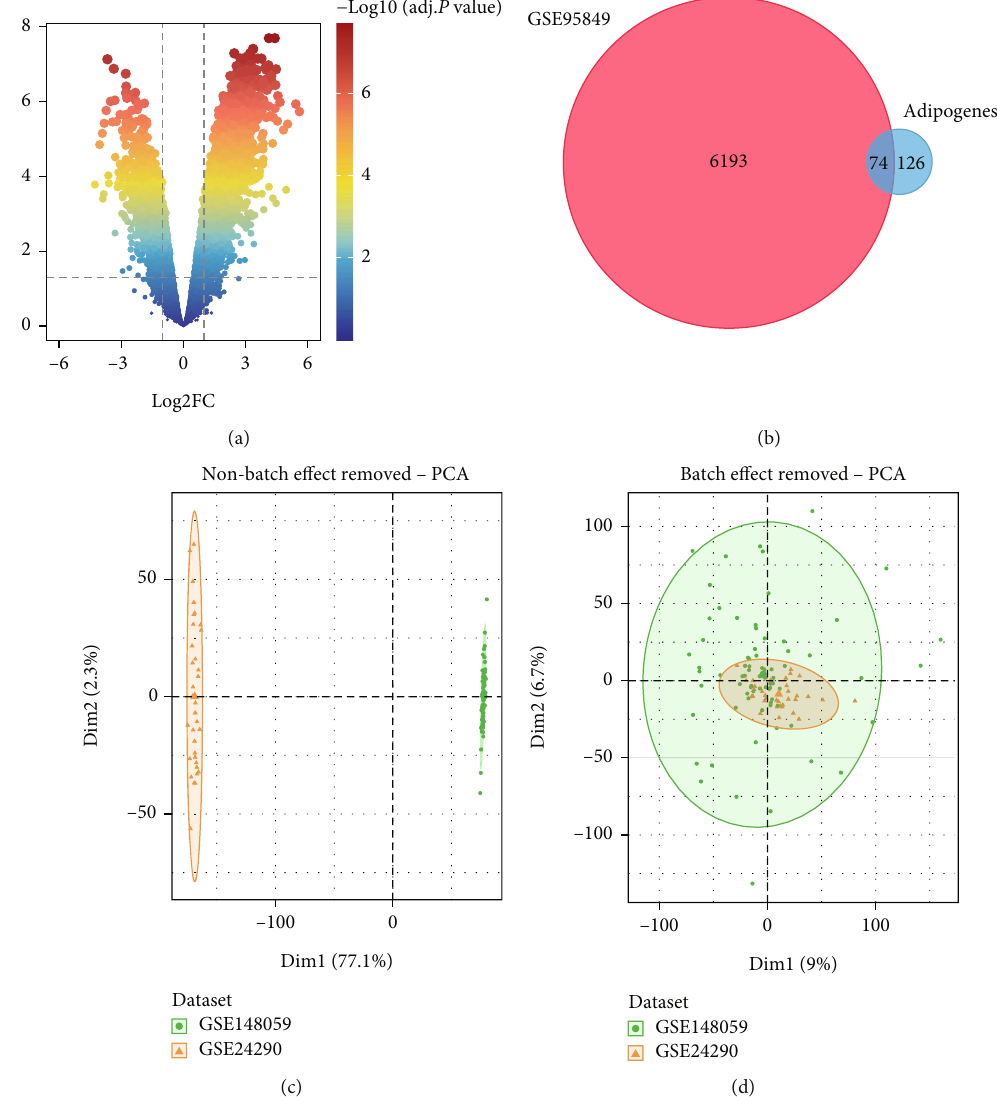
Figure 1: Identi fi cation of DEARGs. (a) Volcano plots of DEGs in GSE95849. Two vertical lines indicate gene expression fold change > 1 and < -1, respectively, and the horizontal line indicates the adjusted p value of 0.05. The color of the dot represents the adjusted p value levels. (b) DEARGs identi fi ed by Venn diagram. The blue circle represents the 200 adipogenesis-related genes from the MSigDB Team, and the red circle represents the 6193 DEGs in GSE95849. (c, d) PCA diagram indicated that after removing the batch e ff ect, samples in two datasets became